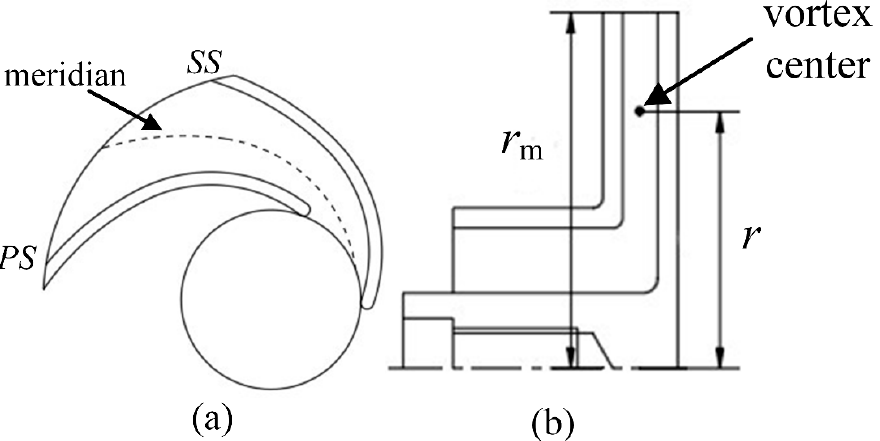
Figure 2. Schematic of flow channel meridian ( a ) and side view of the impeller ( b ); r is the distance from the vortex center to the origin of the impeller, r m is the distance from the impeller outlet to the origin of the impeller.